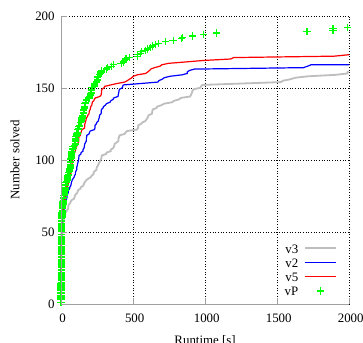
Figure 11. Cumulative number of instances solved in a given run-time by the fastest sequential version ( v 3), our fastest parallel CPU-based implementation ( v 2), the GPU tool ( v 5), and the portfolio approach ( vP